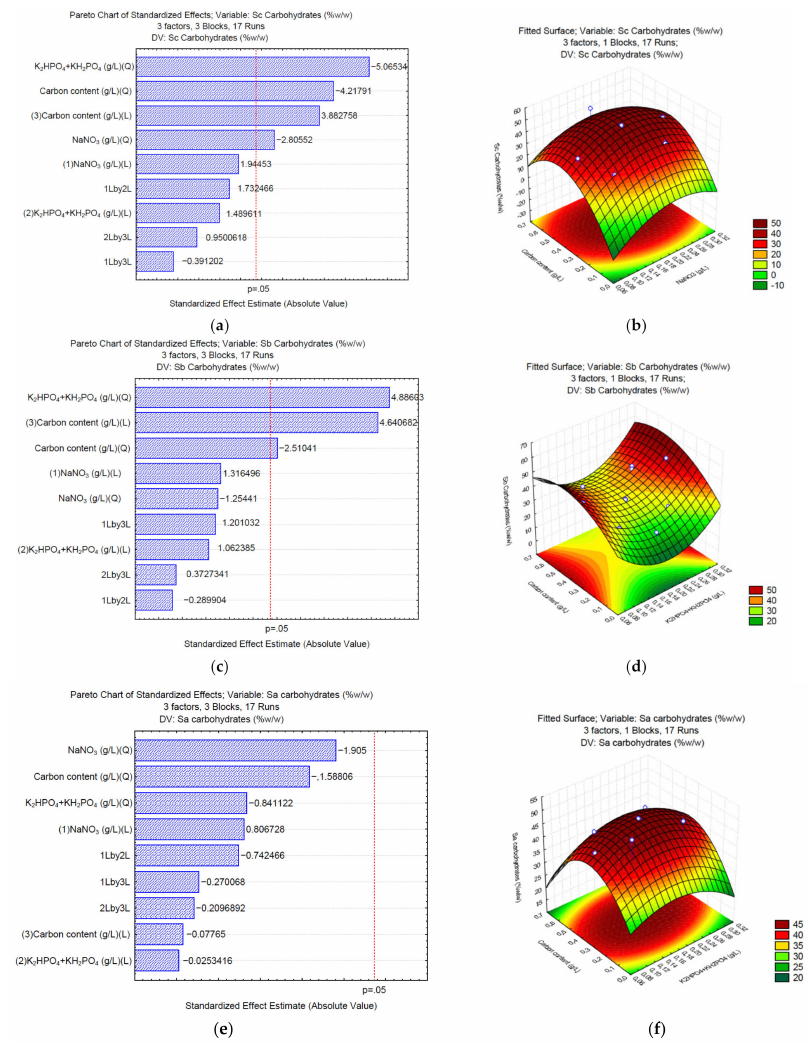
Figure 1. Pareto charts and surface response of carbohydrate production using Na 2 CO 3 ( a , b ), NaHCO 3 ( c , d ), and C 2 H 3 NaO 2 ( e , f